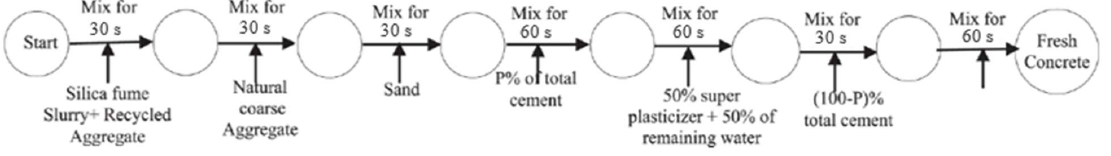
Figure 12. Steps of TSMA mixing [43]. Reproduced with permission from [43], Elsevier, 2020. The RCA was derived from a 45-year-old demolished building located in Dhanbad,